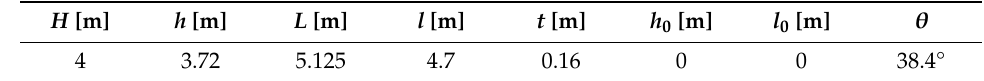
Table 5. Panel geometry.